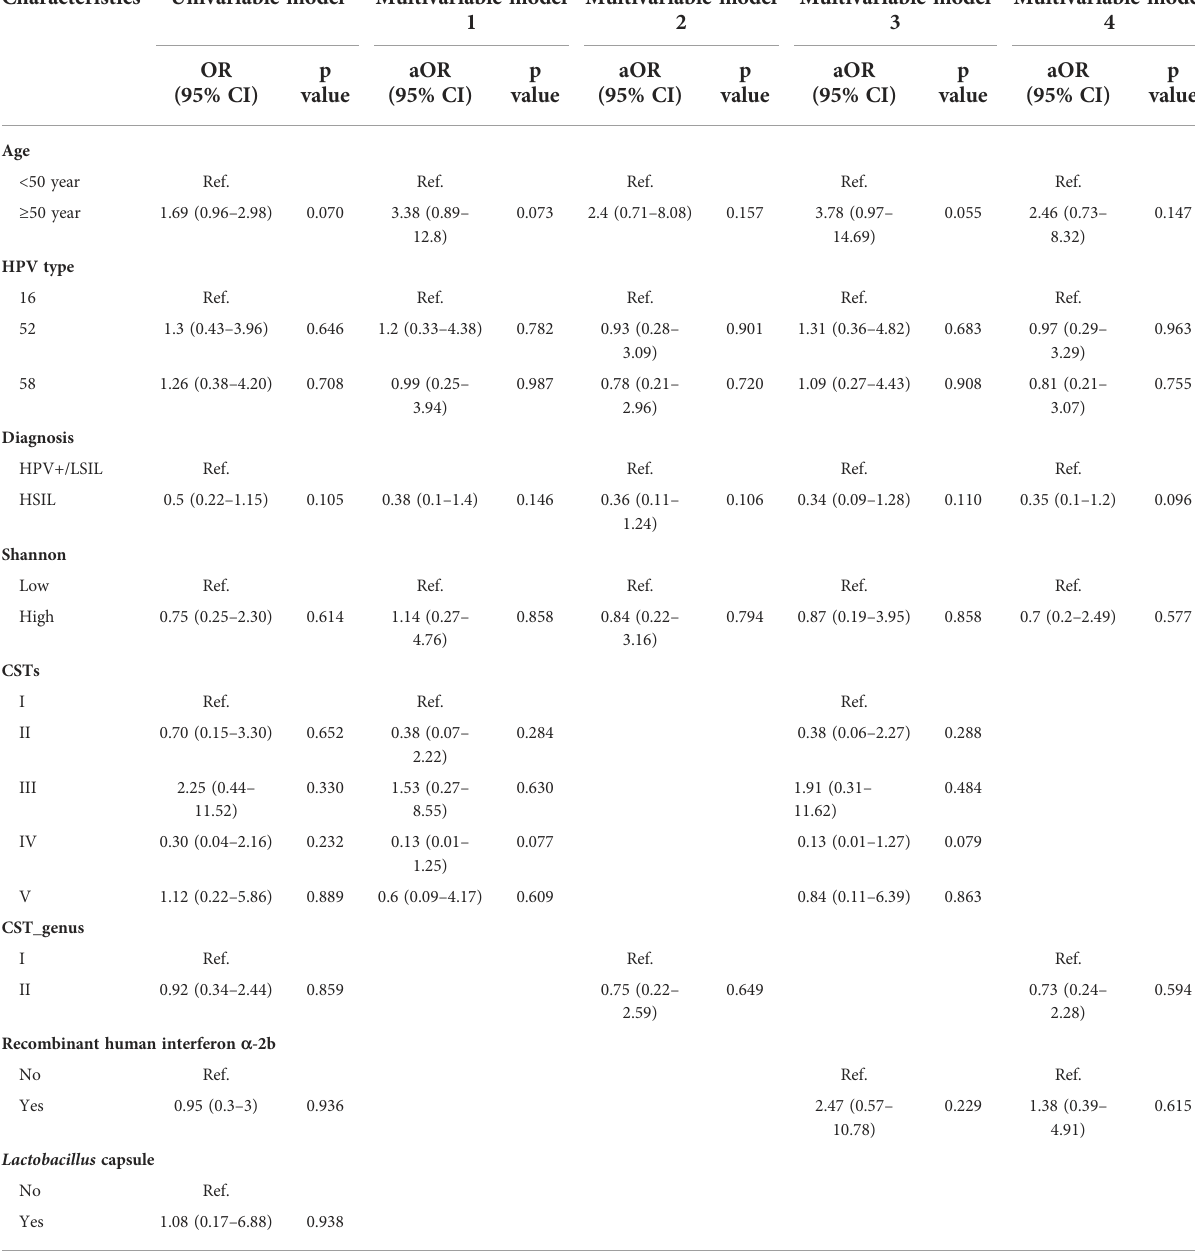
TABLE 2 Association between VM and HPV clearance in a 12-month